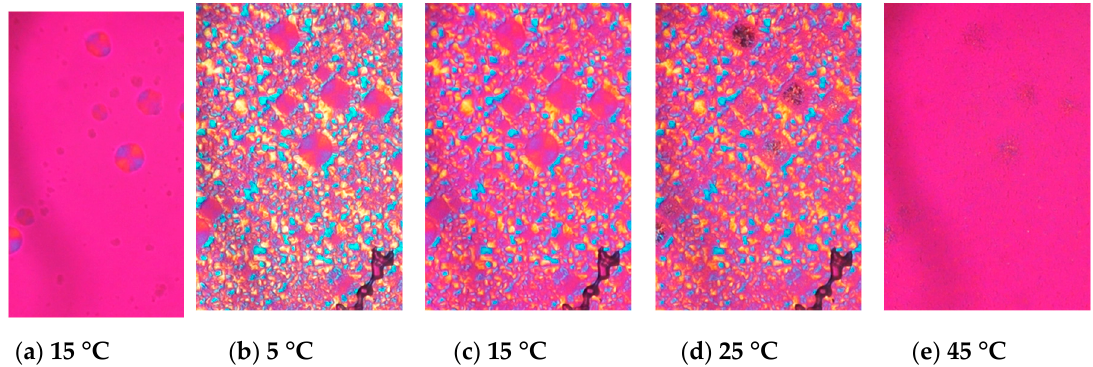
Figure 2. Morphological changes and melting behavior of trilaurin observed by polarized light microscopy at ( a ) 15 and ( b ) 5 ◦ C while cooling and ( c ) 15, ( d ) 25, and ( e ) 45 ◦ C while heating. ( a ) Trilaurin was crystallized in β ’ form at 15 ◦ C, then ( b ) α form covered them. The scale bar is 100 µ m. DSC thermograms of the four β forms obtained from LLL (see 3.2 for sample preparation) are